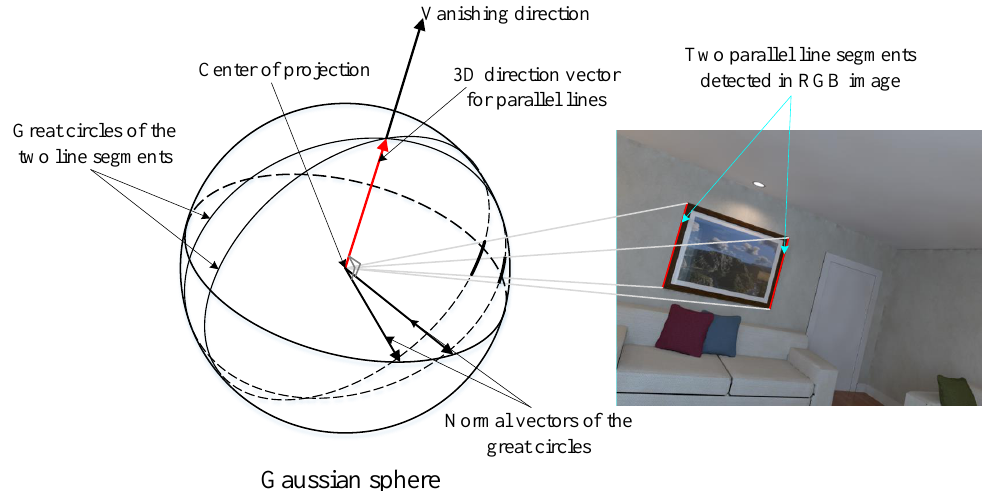
Figure 2. Three-dimensional geometric relationship between parallel lines and their vanishing direction. Gaussian sphere is a unit sphere on the center of a camera projection. Two parallel lines are projected onto the Gaussian sphere as two great circles, and vanishing direction is obtained by the cross project of these two great circles’ normal vectors. Two parallel lines and their corresponding vanishing direction are drawn with